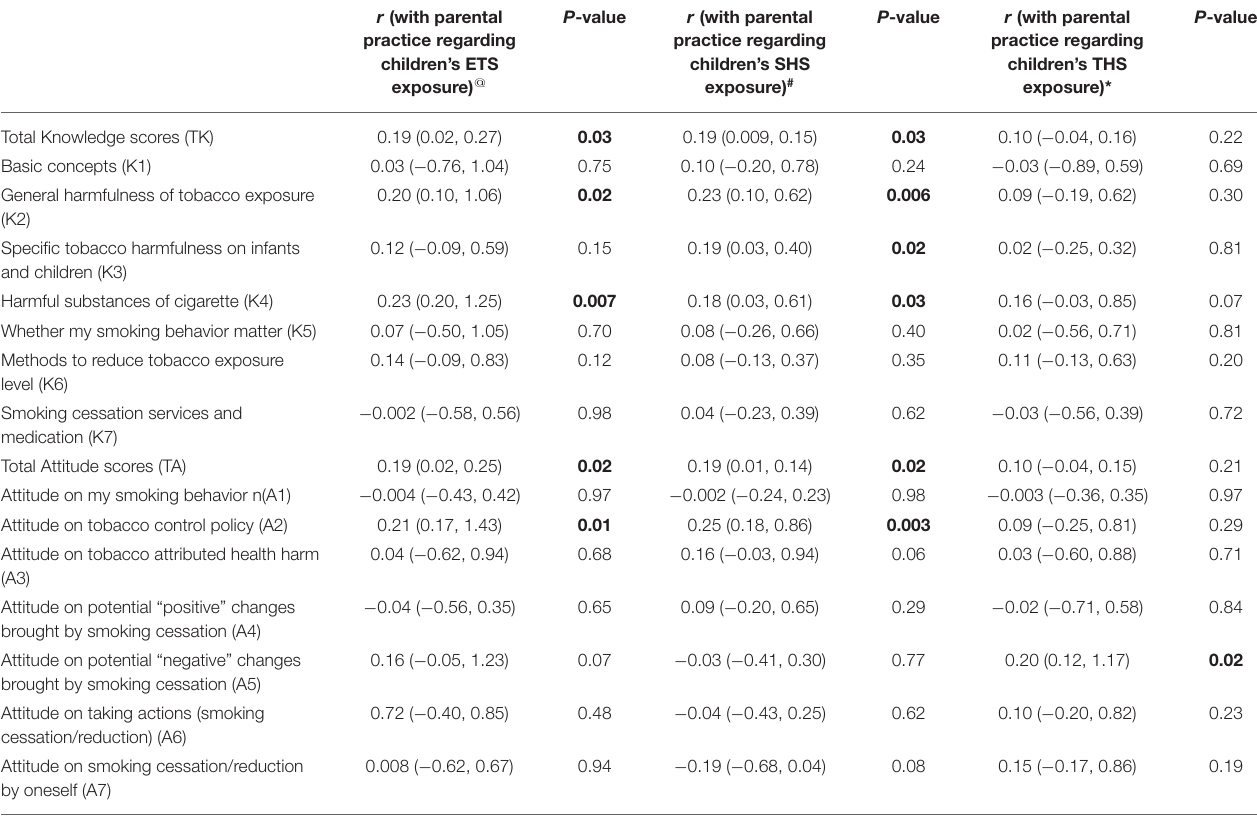
TABLE 5 | Associations between parental total Knowledge, total Attitude, and Practice regarding children’s ETS exposure ( N =